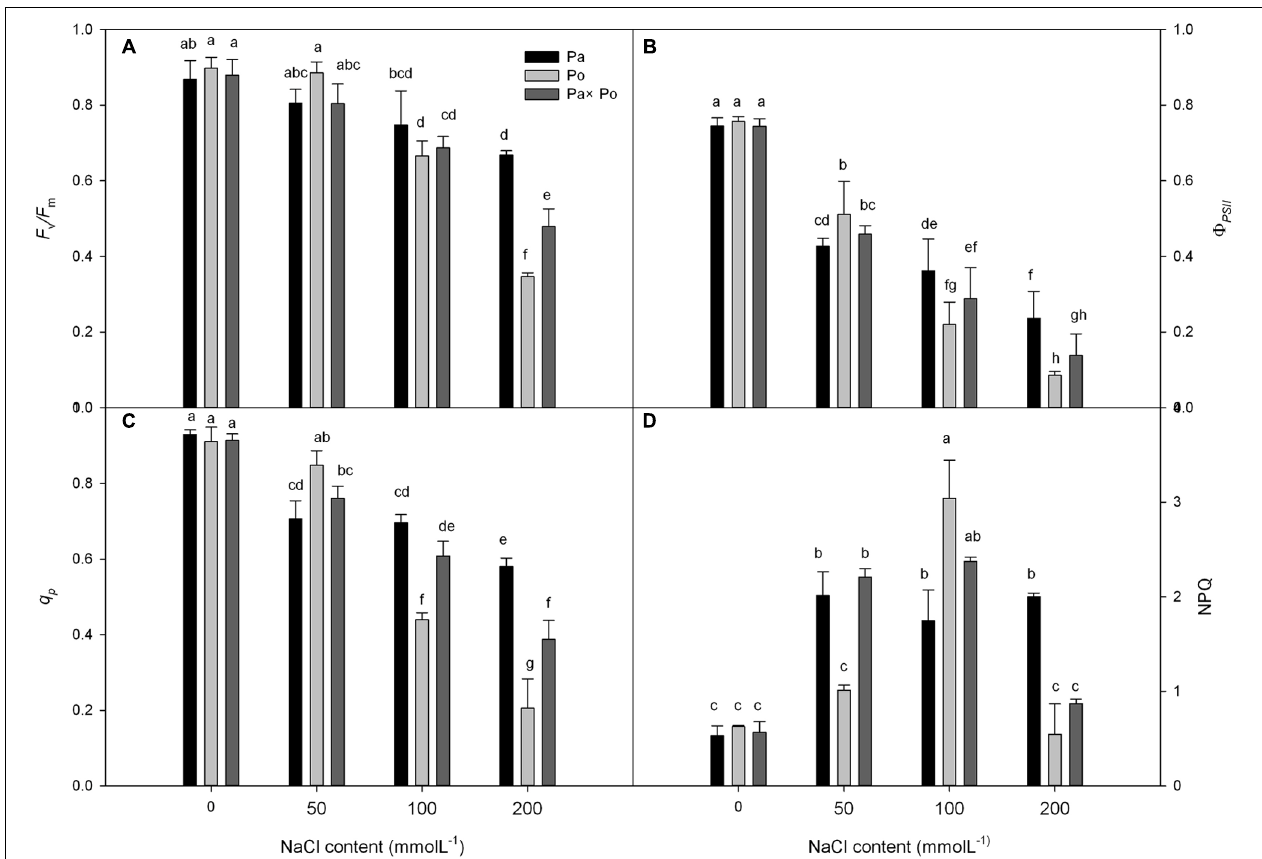
FIGURE 2 | The effect of salt stress on the chlorophyll fluorescence parameters of leaves of three P. amurensis . The PSII maximum photochemical efficiency (A) , actual photochemical efficiency (B) , photochemical quenching coefficient (C) , and non-photochemical quenching (D) . Note: Pa, P. amurensis Maxim ( opulifolius “Diabolo” ( ); Pa × Po, P. amurensis Maxim ( ) × P. opulifolius “Diabolo” ( ). Data in the figure are mean ± SE; values followed by different lowercase letters indicate a significant difference ( p < 0.05). ♂ ♀ ♂